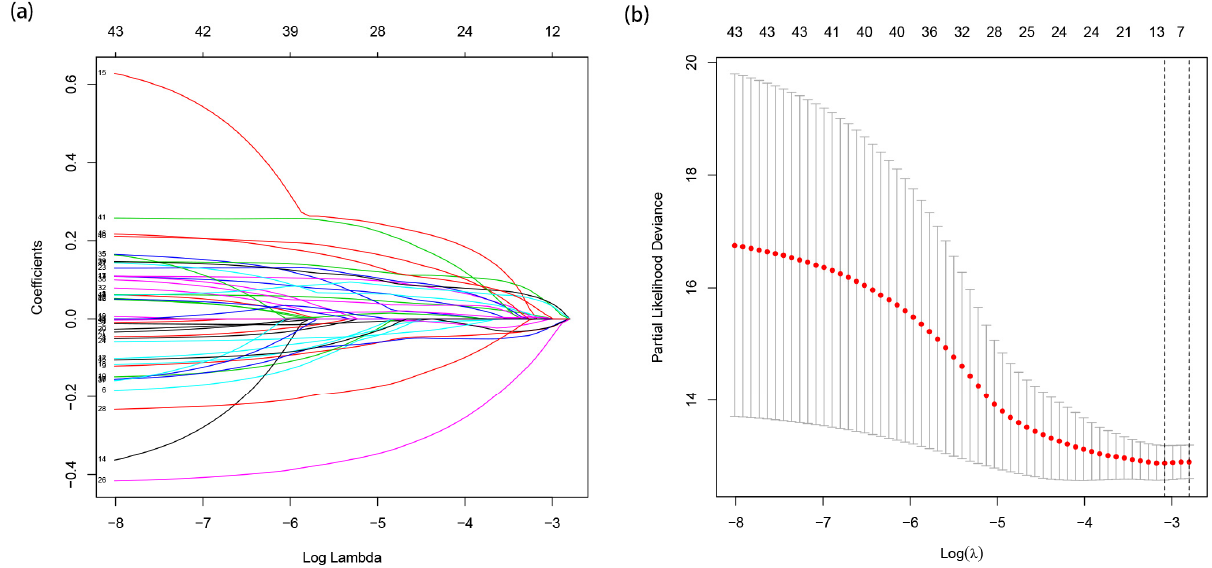
Figure 2. ( a ) Distribution of LASSO coefficients for 47 related miRNAs. ( b ) Partial likelihood bias of the LASSO coefficient distribution. The vertical dashed line indicates the minimum partial likeli- hood deviation.